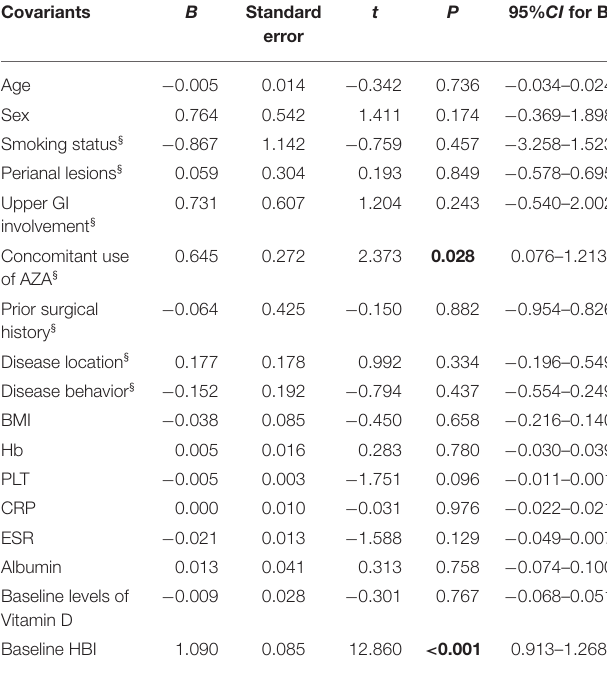
TABLE 4 | Influence factors on the decrease of HBI in CD patients supplemented by vitamin D3 (liner regression, enter) ( n = 37). Covariants